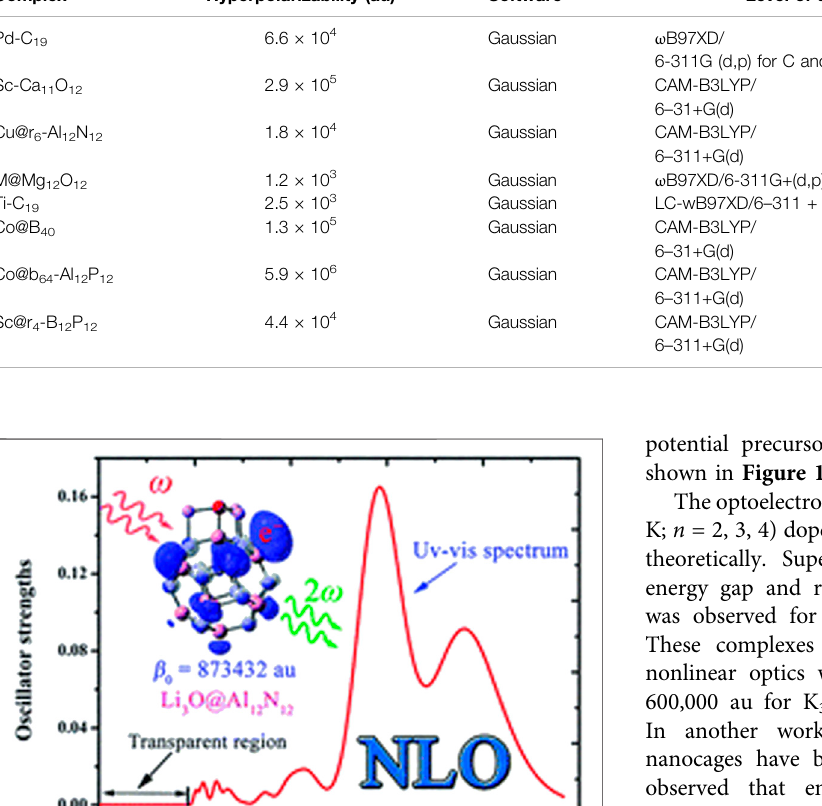
TABLE 4 | Transition metal doped nanocages with enhanced nonlinear optical responses. Complex